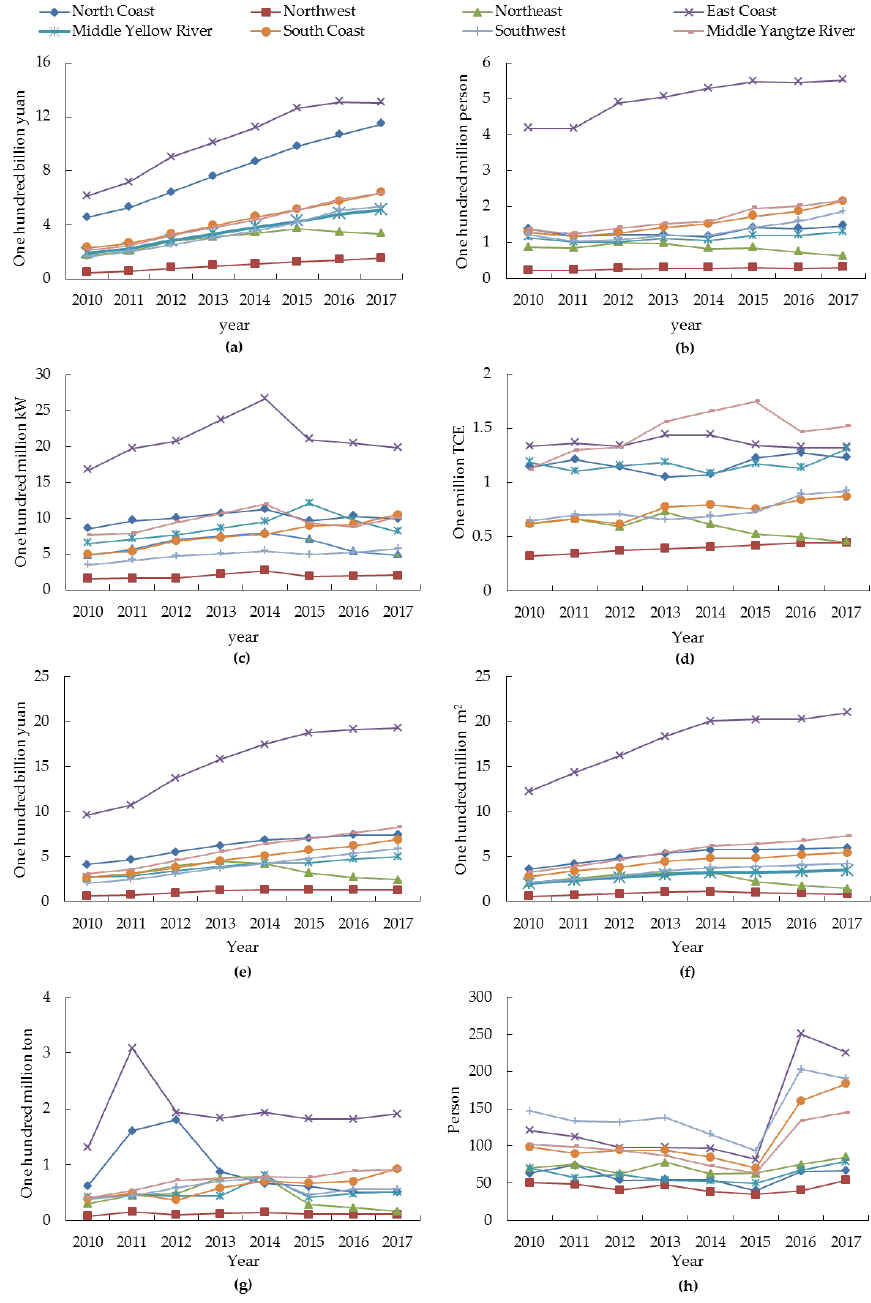
Figure 6. Changes in the average input and output of the eight regions. Inputs: ( a ) TFA ( b ) NE ( c ) TPM ( d ) EC; desirable outputs: ( e ) TOV ( f ) FSC; undesirable outputs: ( g ) CE ( h ) NF.